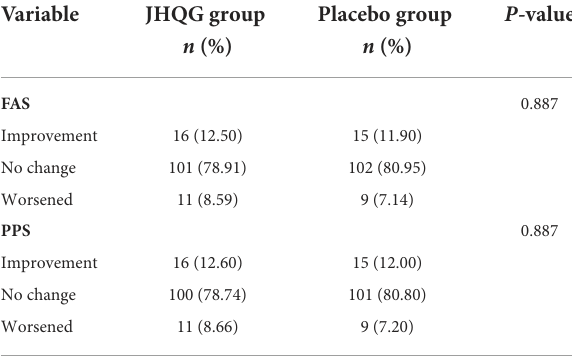
TABLE 7 Change in radiographic findings of the lungs